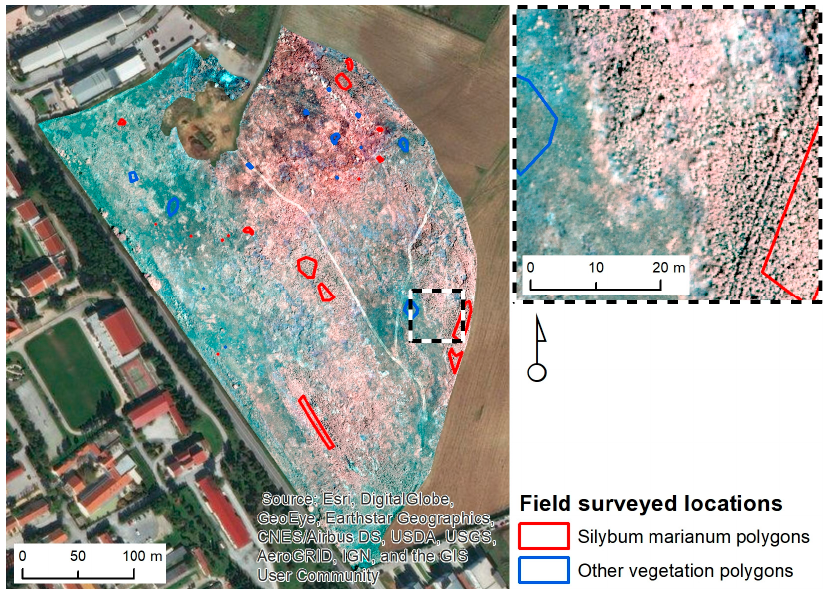
Figure 1. Orientation map and field surveyed locations in the study area.